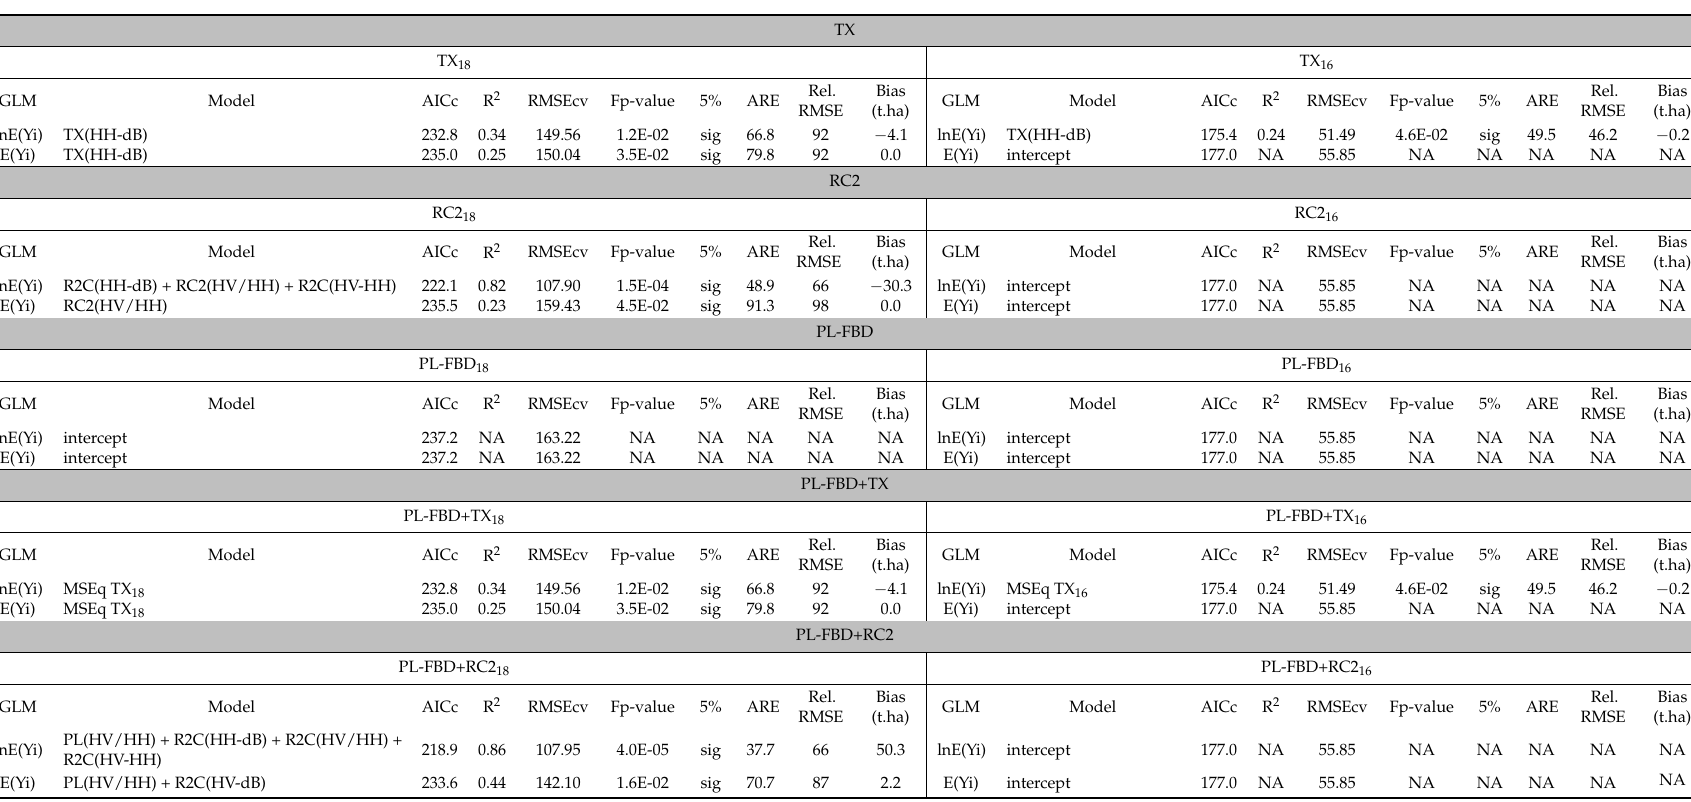
Table 5. GLM model specifications and model evaluation for predicting aboveground biomass from synthetic aperture radar data in floodplain forests of the Amazon